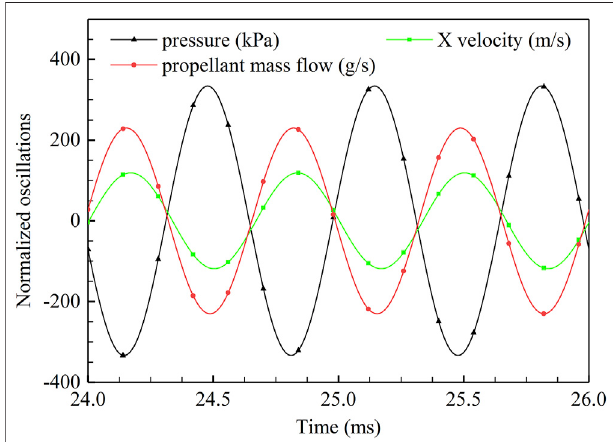
FIGURE 11 | Normalized oscillations of pressure, CH 4 mass fraction, X-velocity, and O 2 mass fraction at probe plane. The signals were band-pass fi ltered with a center frequency of 1,489 Hz and a bandwidth of 100